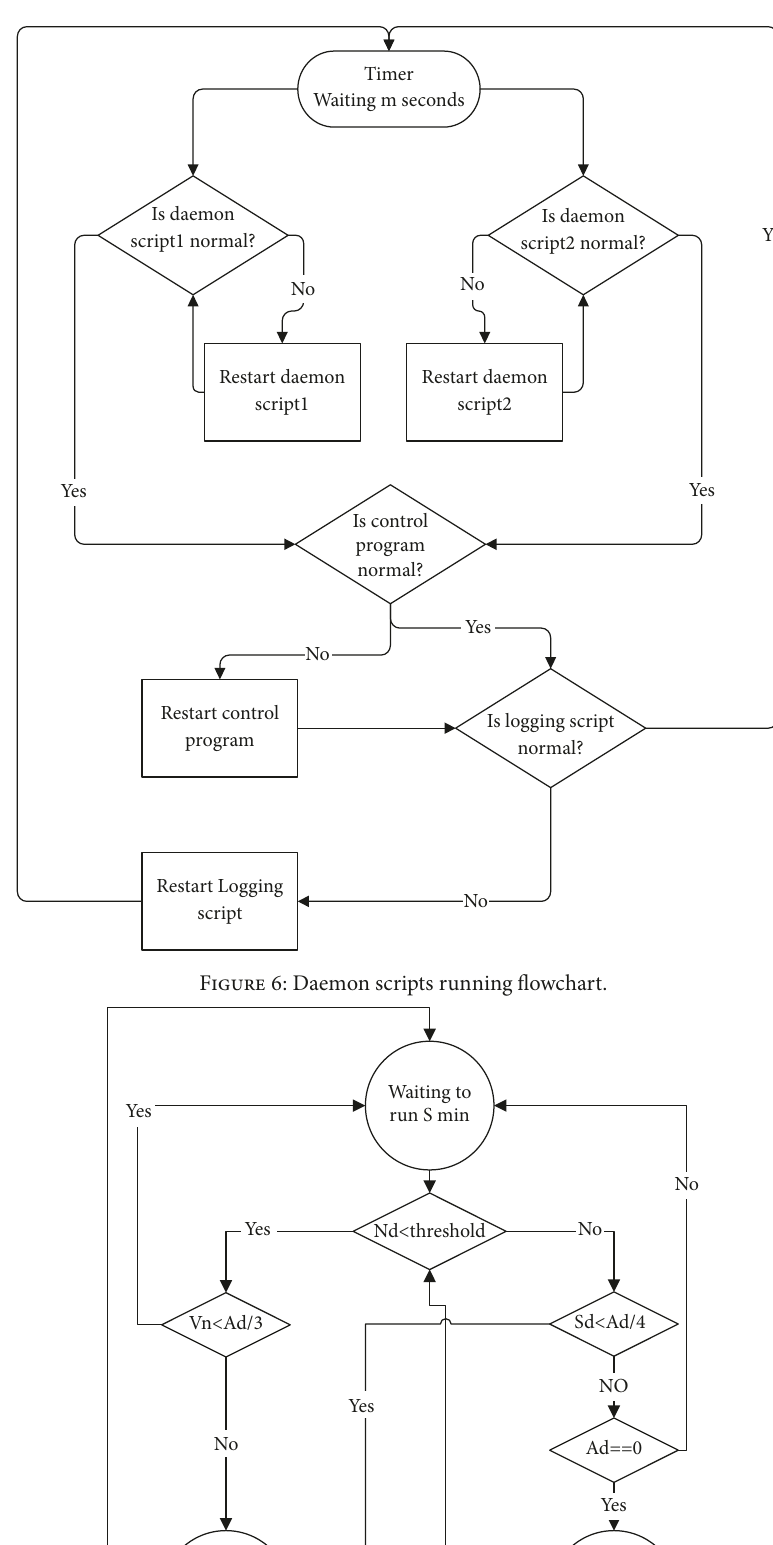
Figure 7: VSAN algorithm